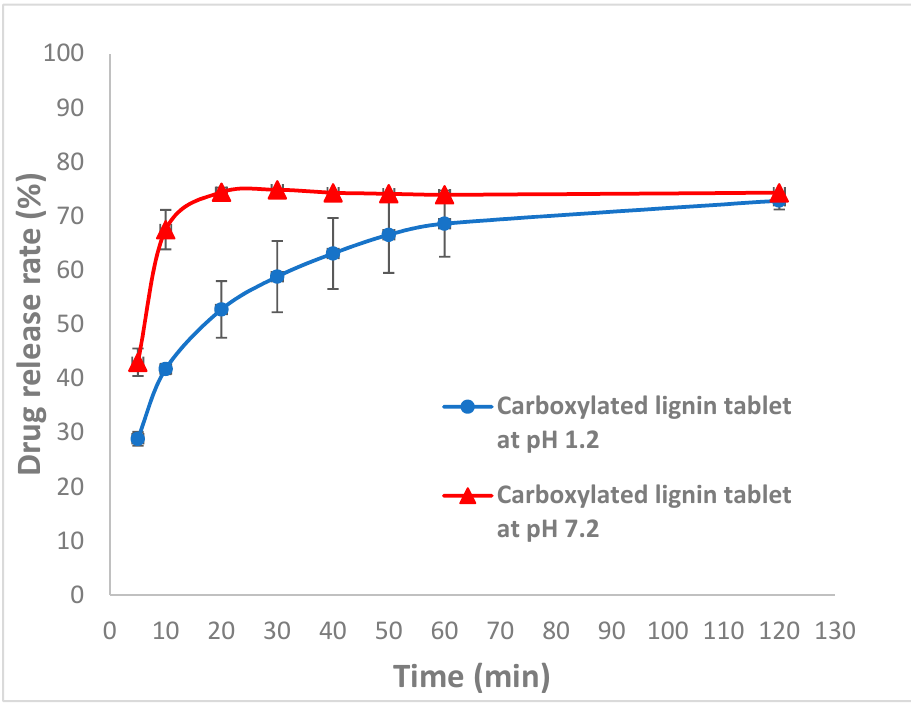
Figure 6. Drug release rate of carboxylated lignin in pH = 1.2 and pH = 7.2.